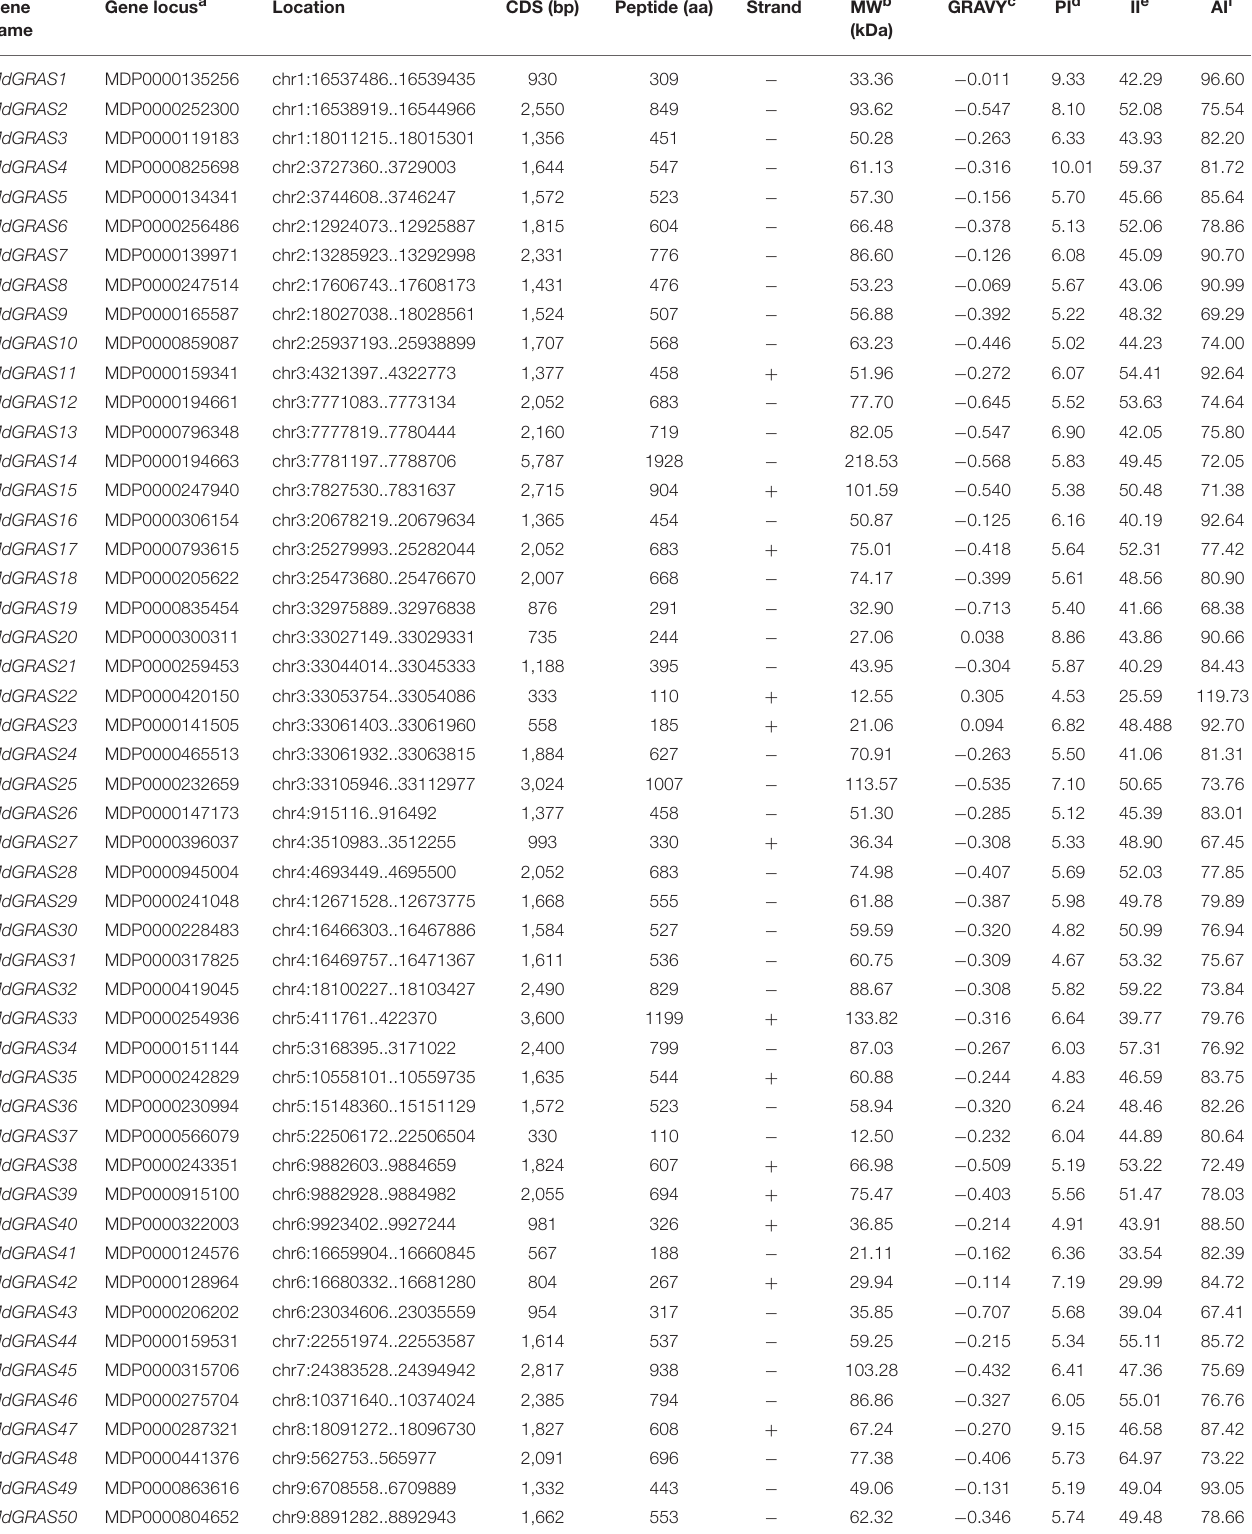
TABLE 1 | List of MdGRAS genes and their chemical